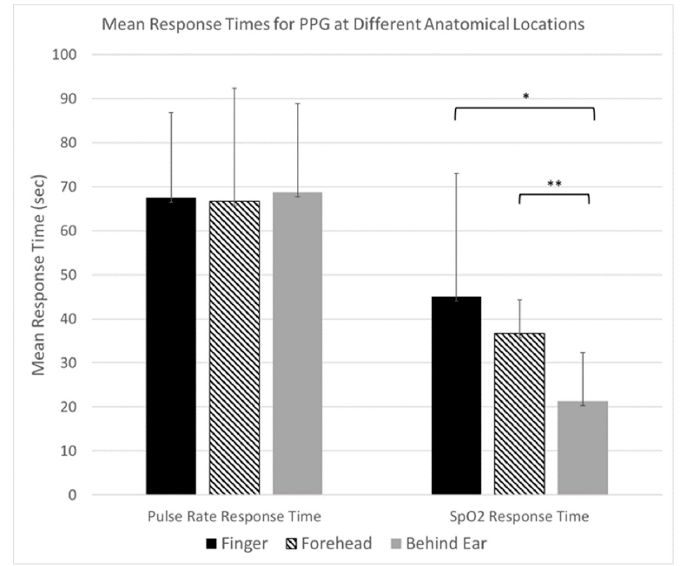
Figure 6. Mean response times comparison for all three locations of PPG readings upon administration of 100% oxygen following hypoxic conditions: Finger (black), Forehead (striped), and Behind the Ear (gray), for Pulse rate and SpO 2 readings, showing similar response times for Pulse Rate and a significantly faster response time for SpO 2 changes behind the ear location compared to both finger and forehead . * - p = 0.077 by students t-test, two-tailed, paired sample, n = 4 ** - p = 0.19 by students t-test, two tailed, paired, n = 3.